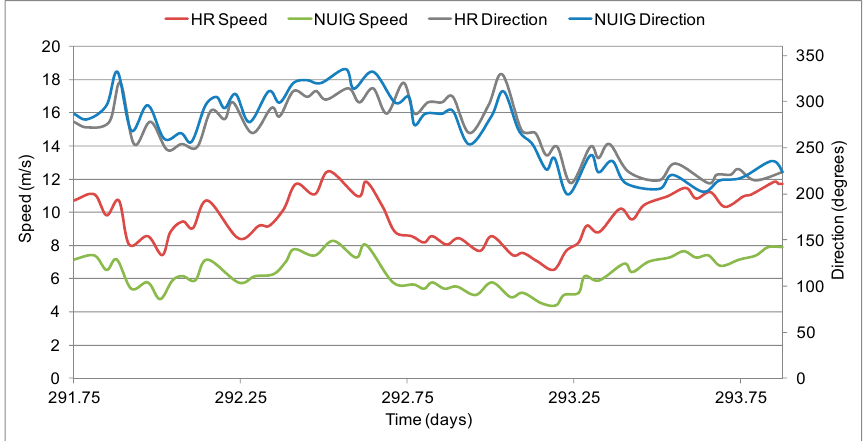
Figure 10. Time series of HR data at A2 against NUIG wind during P2